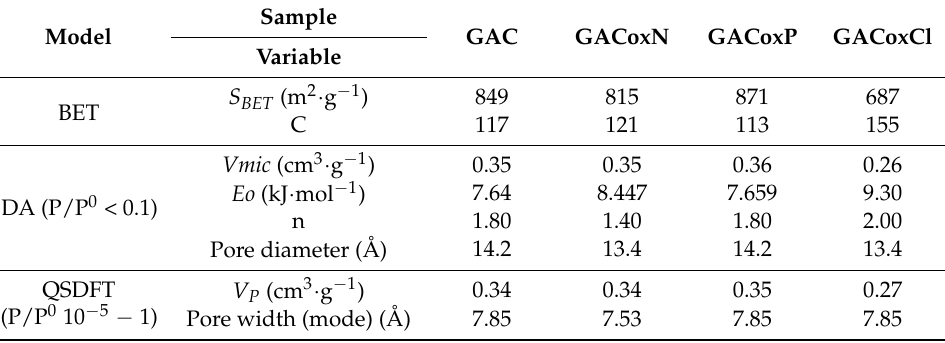
Table 2. Textural properties of activated carbon.